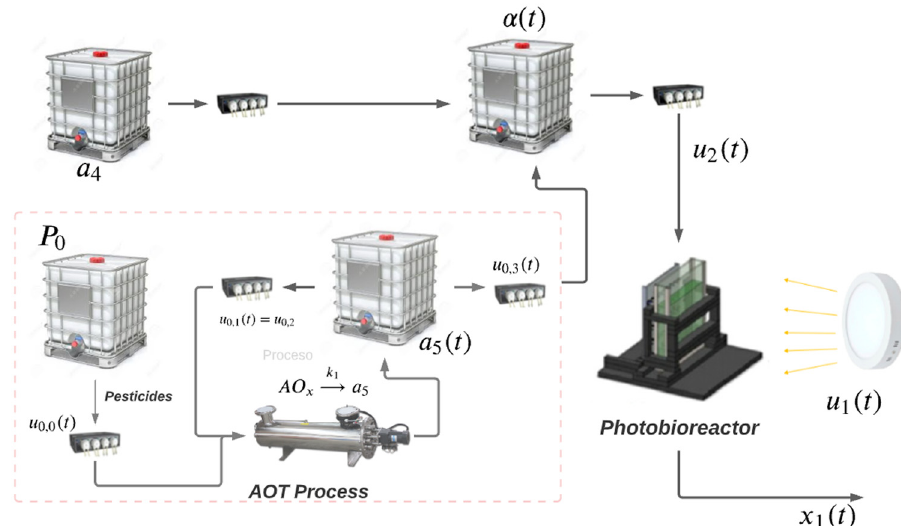
Figure 2: Schematic description of the control